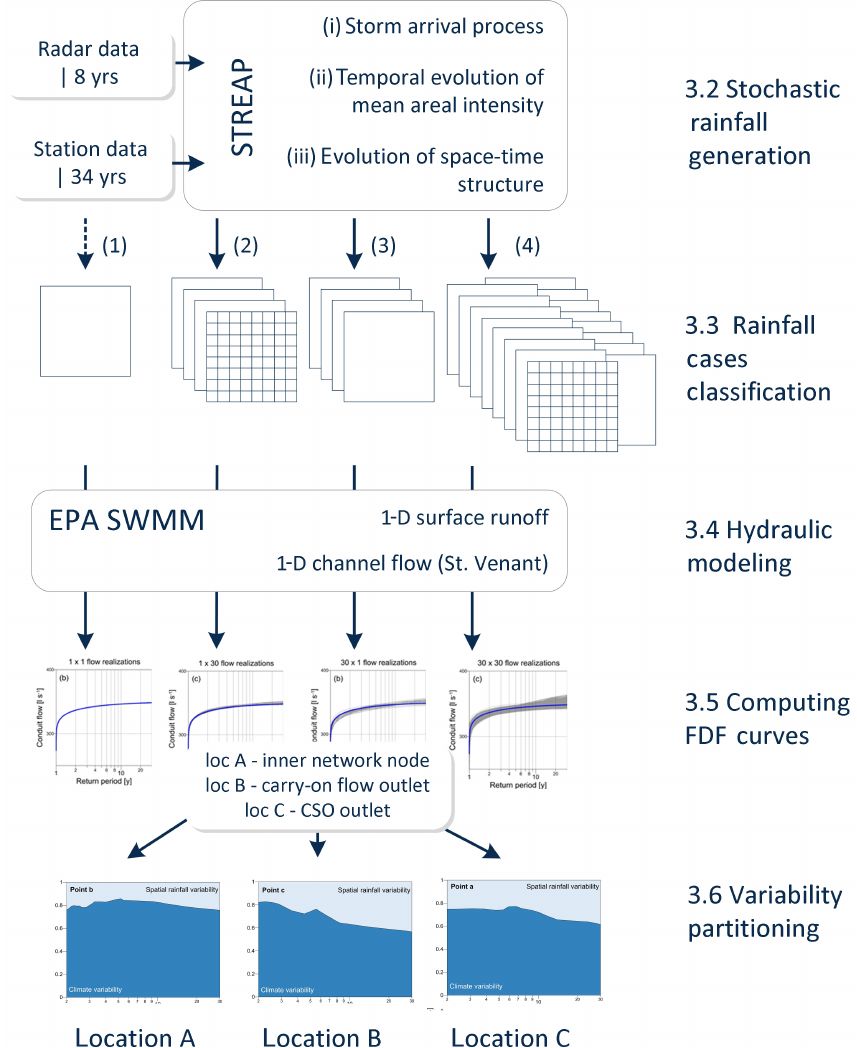
Figure 2. A schematic illustration of the methods used in this study: (i) the STREAP model was used to simulate multiple realizations of 2-D rain fields based on radar and gauged data (Sect. 3.2); (ii) rainfall was generated for four distinct cases which were defined in order to explicitly account for the climate variability, spatial rainfall variability, and total variability of the flow (3.3); (iii) the EPA SWMM model was used to calculate the flow over the catchment (3.4); (iv) IDF and FDF curves were computed for the annual maxima of the mean areal rainfall and flow, respectively, at three different locations (3.5); and (v) the total flow variability was partitioned (3.6).